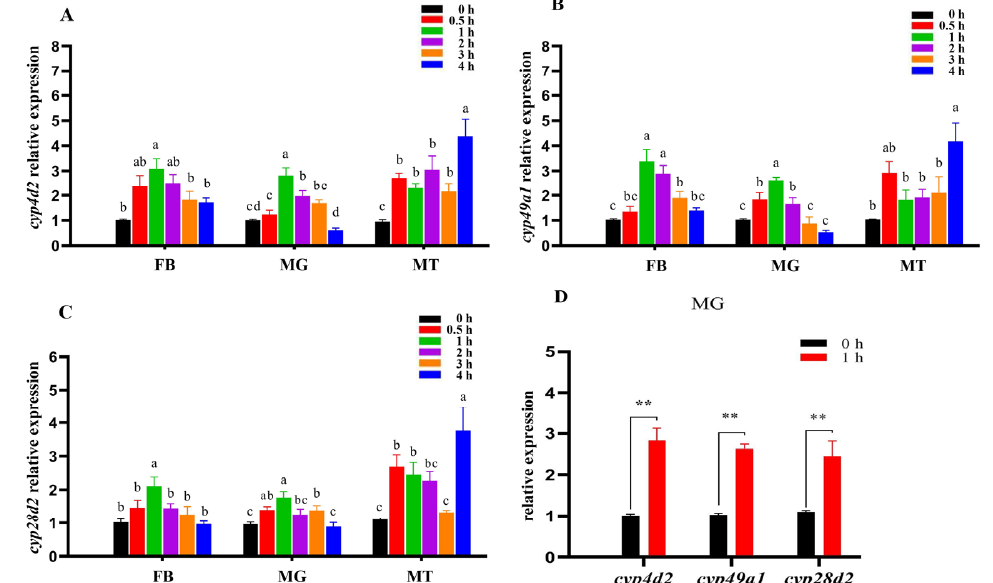
Figure 2. Spatiotemporal expression profiles of Pocyp4d2 , Pocyp49a1 , and Pocyp28d2 in different tissues of P. okadai after β -cypermethrin treatment (X ± s, n = 4). The spatiotemporal expression profile of ( A ) cyp4d2 , ( B ) cyp49a1 , and ( C ) cyp28d2 . ( D ) Relative expression levels of Pocyp4d2 , Pocyp49a1 , and Pocyp28d2 in MG. Note: Different letters above bars indicate significant differences between groups (Duncan’s multiple range comparison; ** p < 0.01).